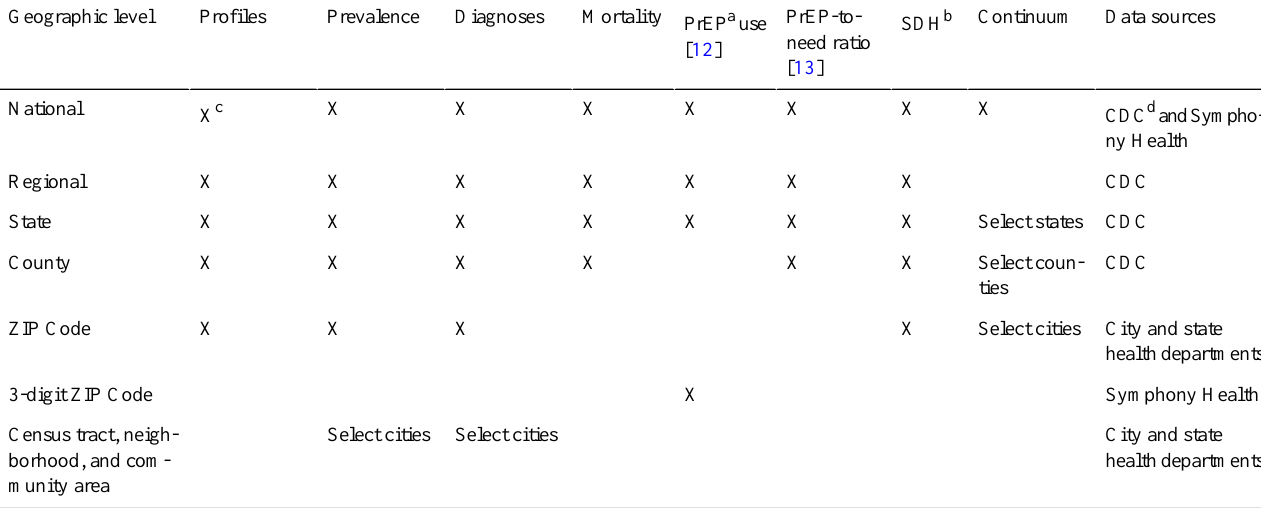
Table 1. Availability of data by visualization type from the AIDSVu Project, July 2020.